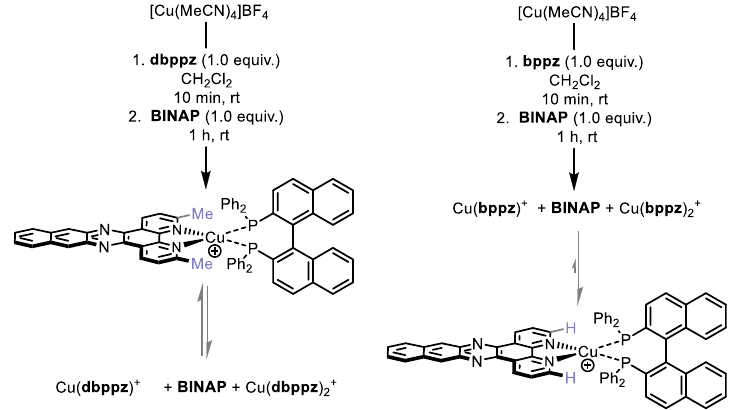
Figure 2. Synthesis of heteroleptic copper-based complexes using BINAP.